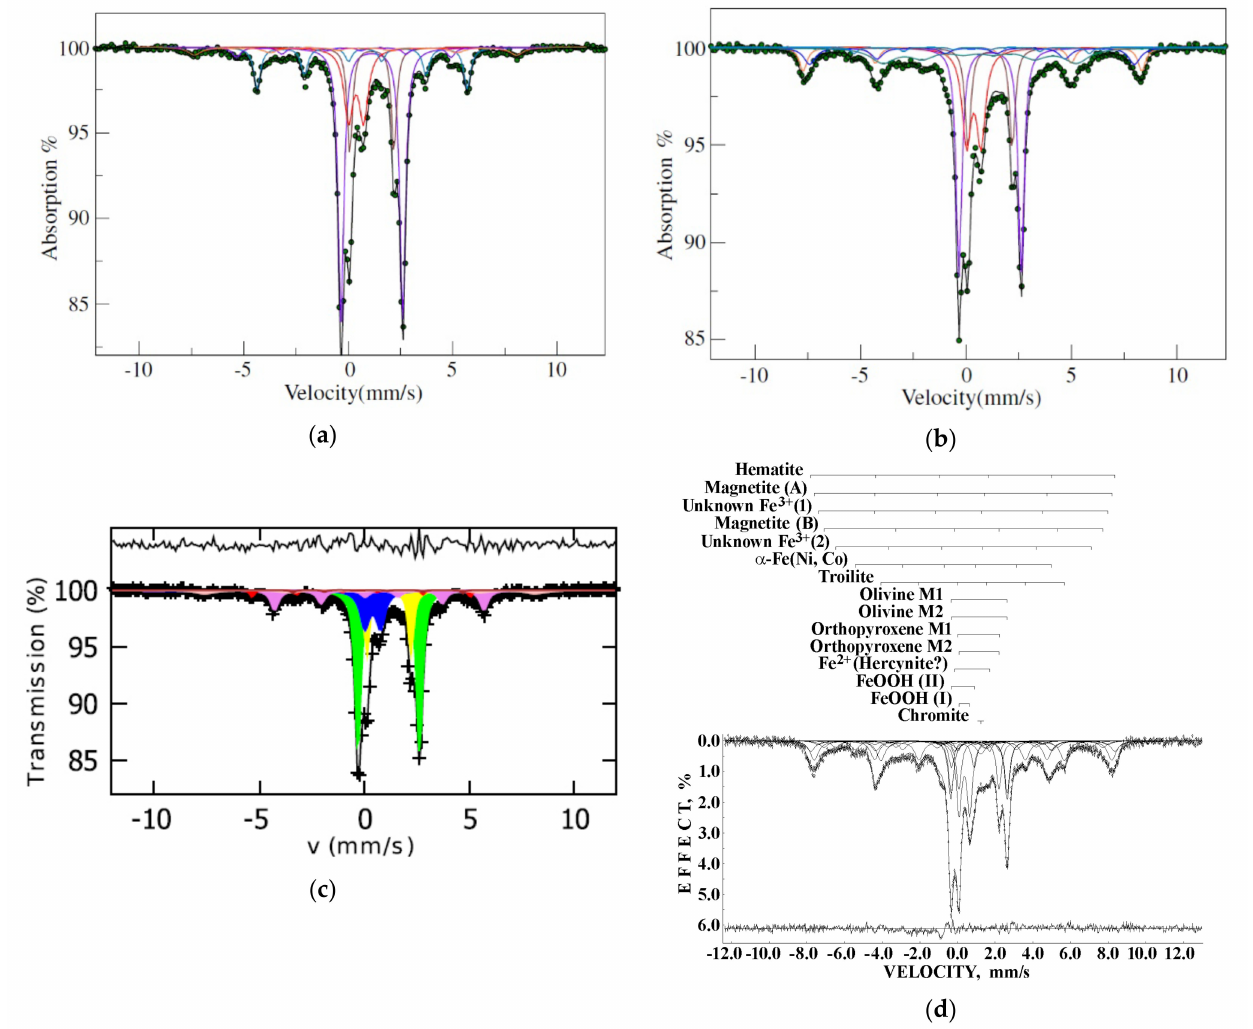
Figure 46. Room temperature Mössbauer spectra of weathered ordinary chondrites Camel Donga 007 L5 ( a ), Gunnadorah 002 L5 ( b ), Lynch 001 L5-6 ( c ) and Gandom Beryan 008 H5 ( d ). The spectra ( a – c ) were measured with a low velocity resolution while the spectrum ( d ) was measured with a high velocity resolution. Indicated components are the results of the fits. The differential spectra are shown on the top ( c ) and bottom ( d ). Adapted from References